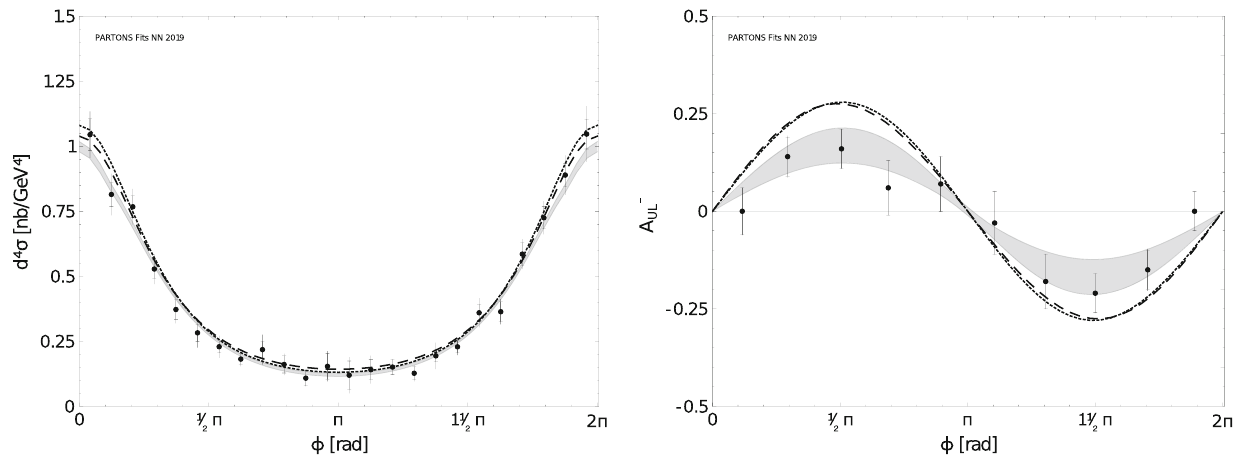
Fig. 12 Comparison between the results of this analysis, the selected GPDmodelsandexperimentaldatapublishedbyCLASinRefs.[51,52] at x Bj = 0 . 244, t = − 0 . 15GeV 2 and Q 2 = 1 . 79GeV 2 (left) for d 4 σ − UU and for A − at x Bj = 0 . 2569, t = − 0 . 23 GeV 2 , Q 2 = 2 . 019 GeV 2 UL (right). The gray bands correspond to the results of this analysis with